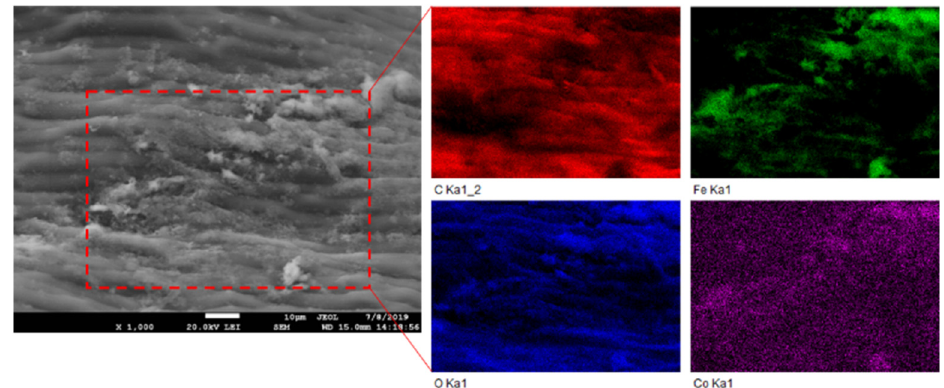
Figure 8. SEM image and EDX elemental maps of magnetically responsive biomass after Co 2+ adsorption. The elemental maps show C, Fe, O, and Co concentrations in an area enclosed by red dashed lines.